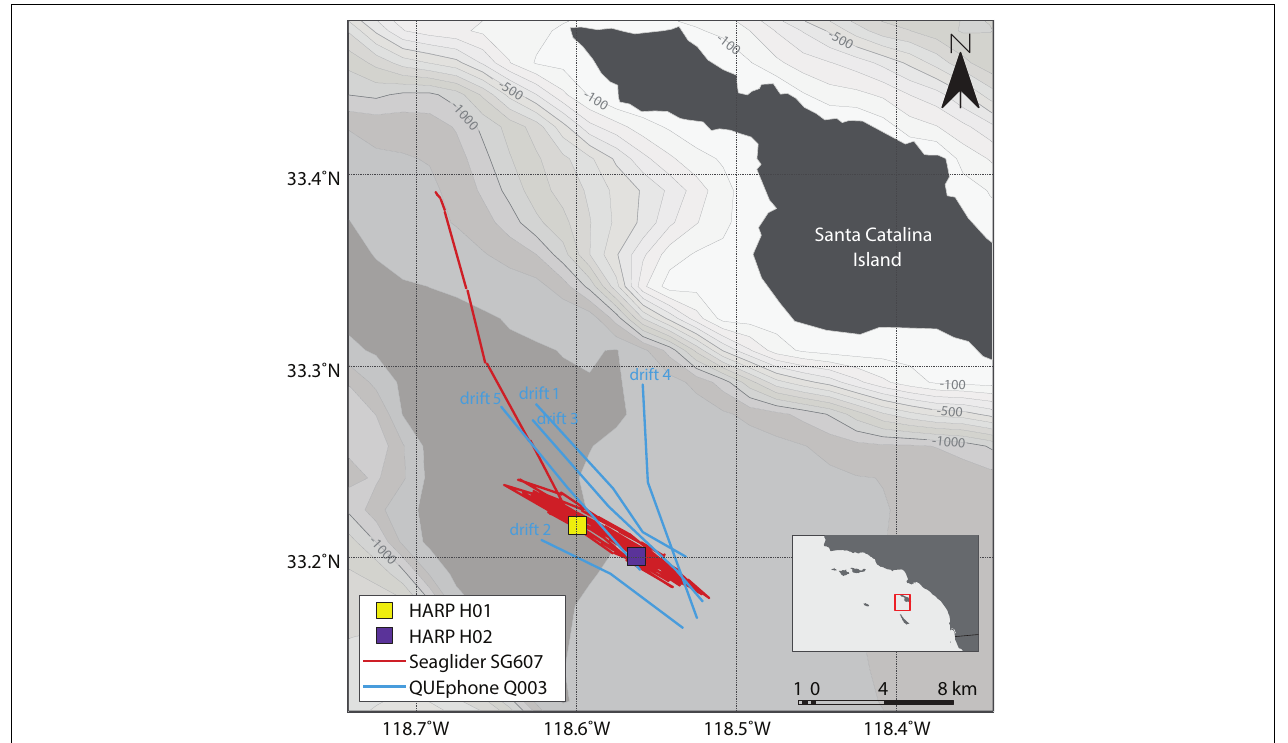
FIGURE 1 | Map of deployment area and recording platform locations. HARPs H01 and H02 are shown as colored squares (yellow and purple). Red lines indicate the glider track; the portion departing to the north was when the glider was directed closer to shore for recovery at the end of the experiment. Blue lines indicate QUEphone drift tracks and are labeled in chronological order. Drift direction of the QUEphone was generally from the southeast to the northwest. Mobile platform tracks are straight line interpolations between known GPS surface locations. Bathymetry is shown in 100 m contours from – 100 m (lightest gray) to – 1300 m (darkest gray). Bathymetry data is from NOAA’s National Centers for Environmental Information (Amante and Eakins, 2009). The inset shows the Channel Islands and Southern California Bight Region of Southern California with the study area outlined in